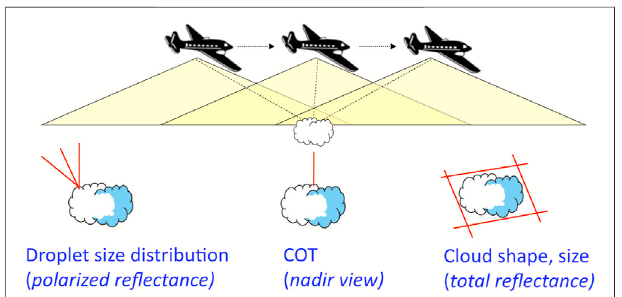
FIGURE 1 | Schematic representation of the RSP ’ s measurement geometry (top) and the view-line aggregations used for different types of retrievals